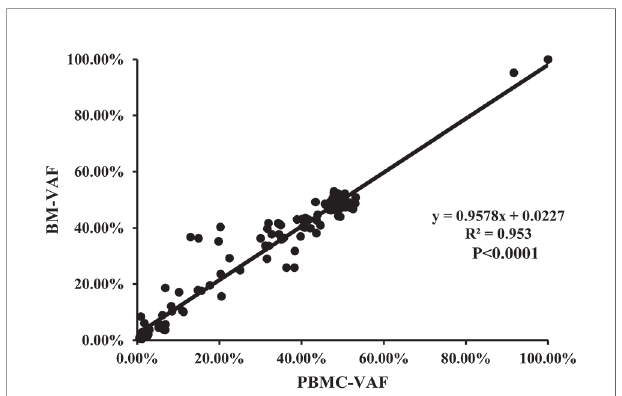
FIGURE 5 | The correlation of the VAFs in the same mutation site detected in BM and ctDNA among the 84 mutations with clinical signi fi cance detected by both assays.